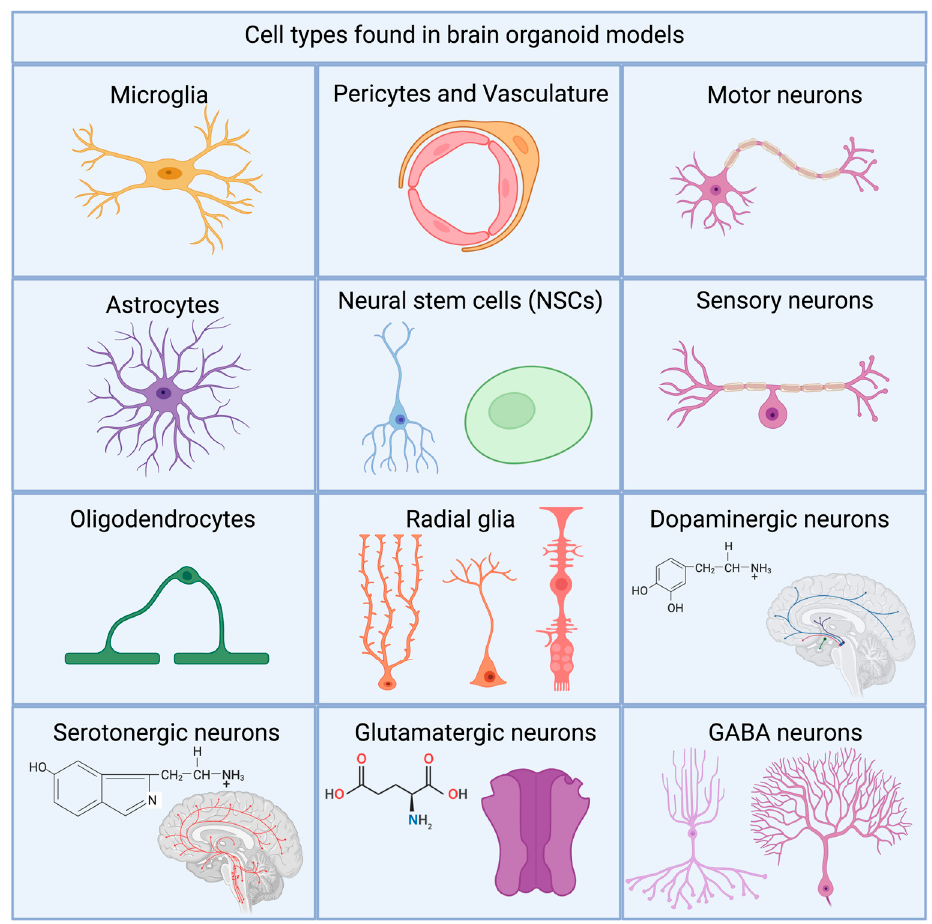
Figure 3. Non-exhaustive schematic overview of the different types of cells found in different organoid